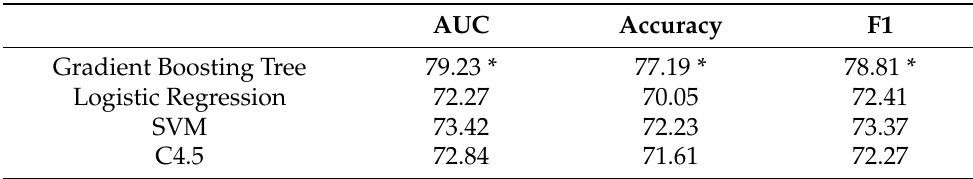
Table 4. Performance of QCB sessions classification. AUC Accuracy F1 Gradient Boosting Tree